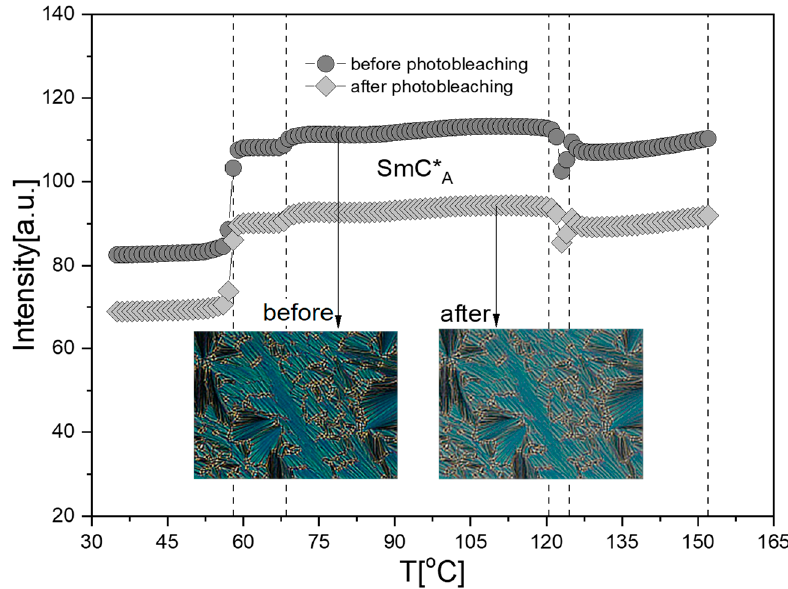
Figure 3. Temperature dependence of the intensity of gray scale obtained by color texture analysis (CTA) before and after photobleaching procedure. Textures of the SmC* A phase registered during cooling with rate 1 °C/min in MHPOBC + 0.1wt.%DANS, cross polarizers, 100 °C.